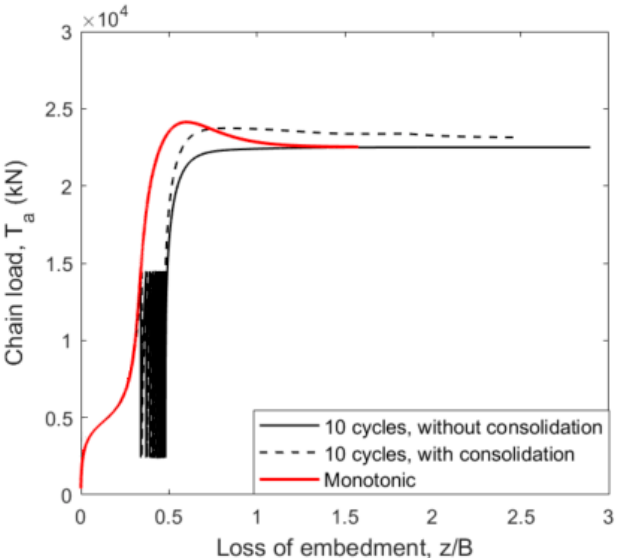
Figure 12. Effect of the evolution of soil strength during 10 cycles of cyclic loading with a frequency of 0.4 Hz.